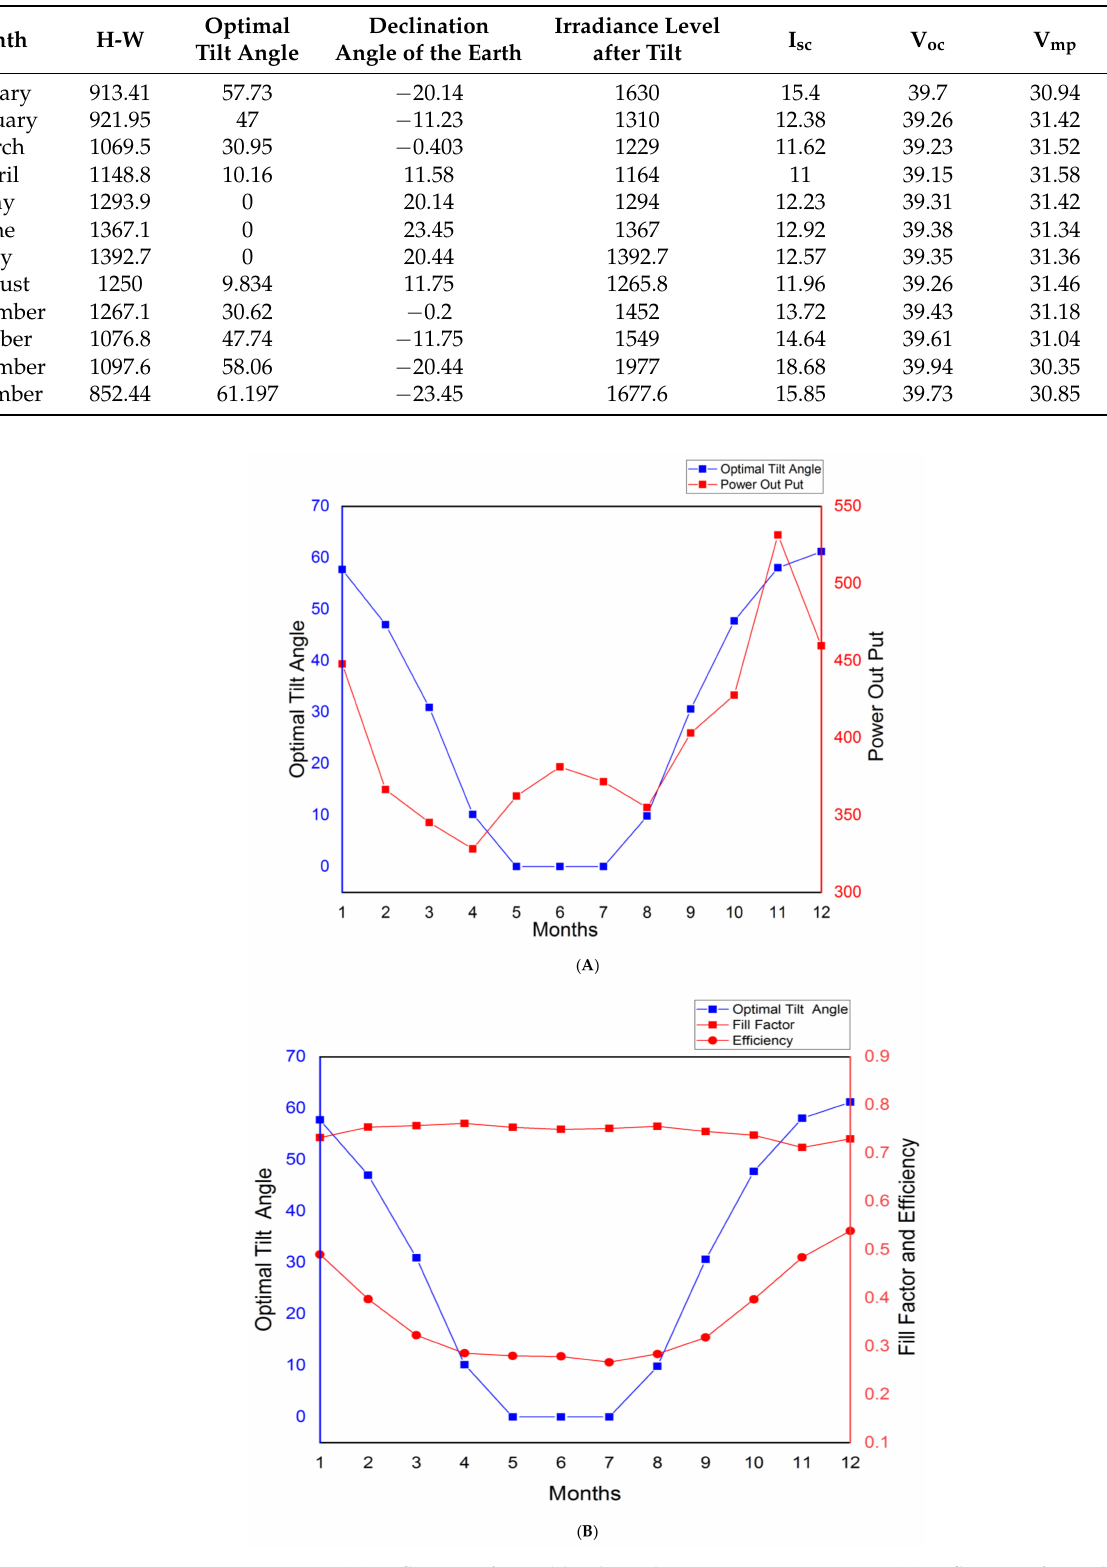
Figure 9. ( A ) Influence of variable tilt angles on PV power output. ( B ) Influence of variable tilt angles on efficiency and fill